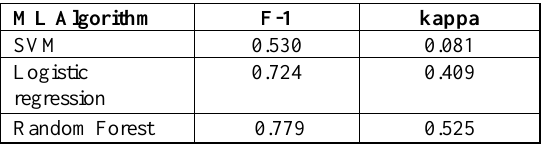
Table 3. F-1 and kappa statistics of three MBT prediction models.